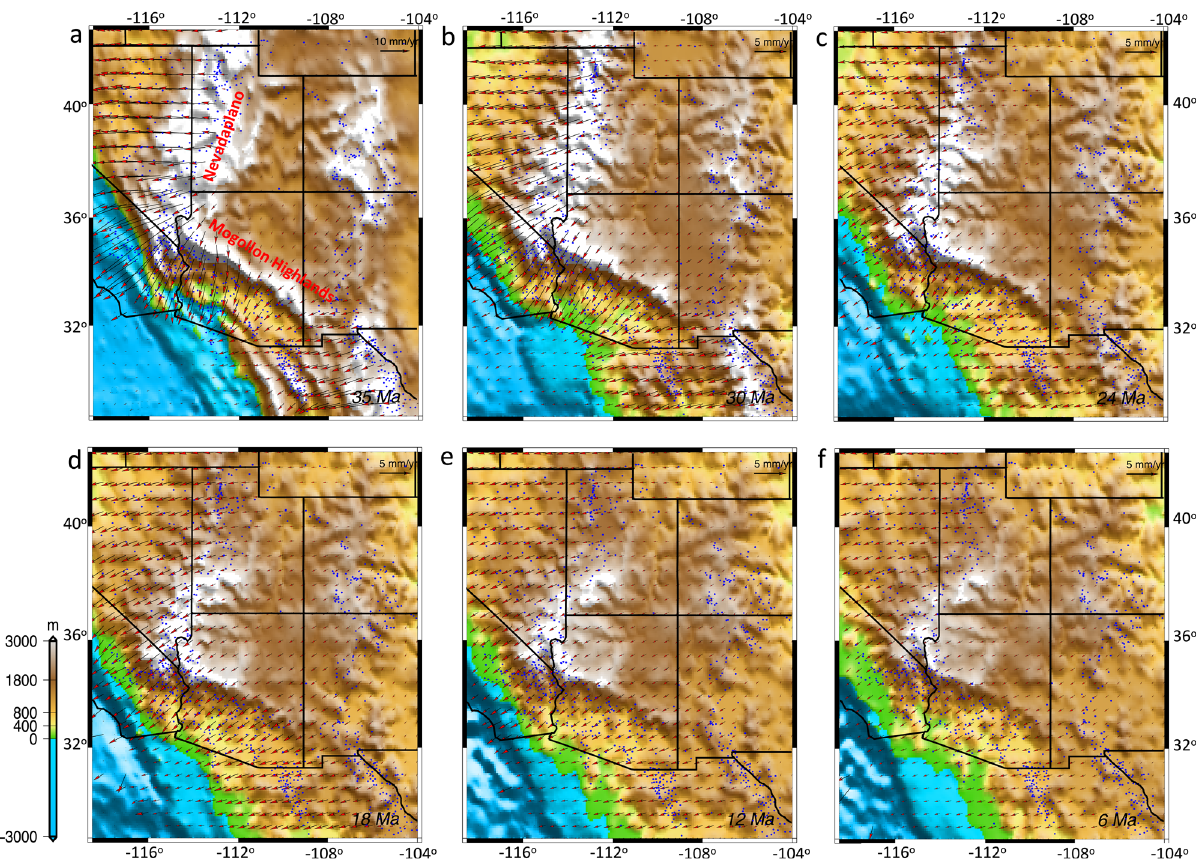
Fig. 8 Kinematic evolution of the upper crust of the North American lithosphere. a – f Red arrows represent displacement rates of the upper crust at 35, 30, 24, 18, 12, and 6 Ma, respectively. Blue spots are the location of normal fault offset observations from McQuarrie and Wernicke 20 and Bahadori et al. 9 . The map images were created by authors using: www.soest.hawaii.edu/gmt/ and